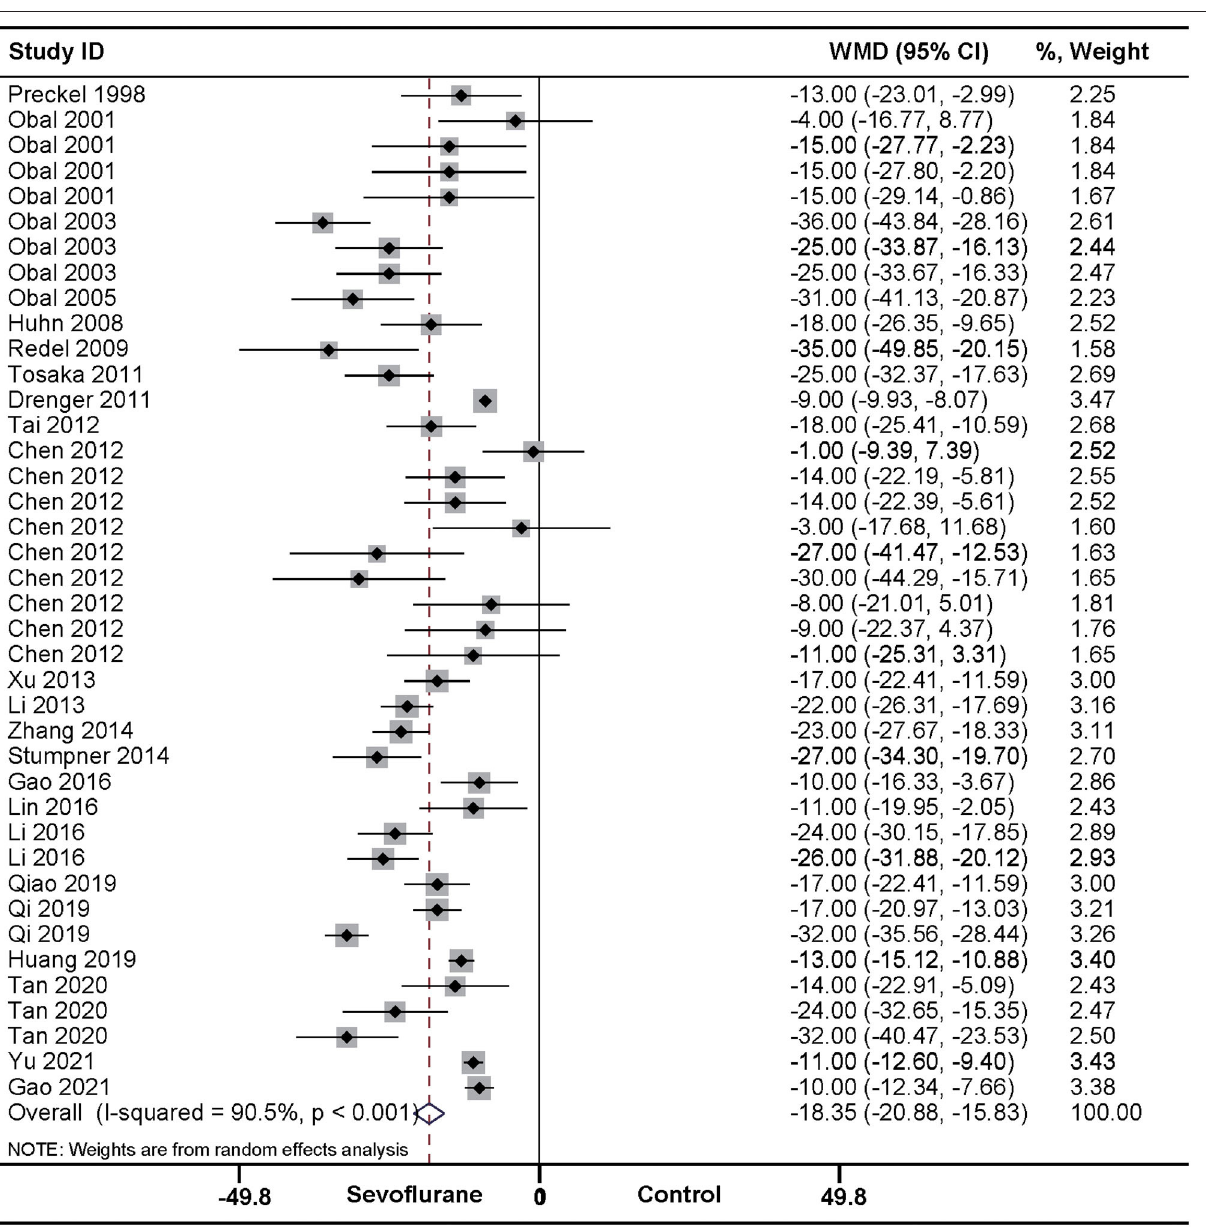
FIGURE 3 | Pooled estimates of infarct size for sevoflurane postconditioning (SPostC) vs. control. Forest plots of meta-analysis of SPostC on myocardial infarct size pooled using a random-effects meta-analysis. The study ID is represented by last name of first author and year of publication. If a study ID is repeated, it indicates that same study involves different intervention protocols. Please refer to the details of intervention protocols in Table 1B